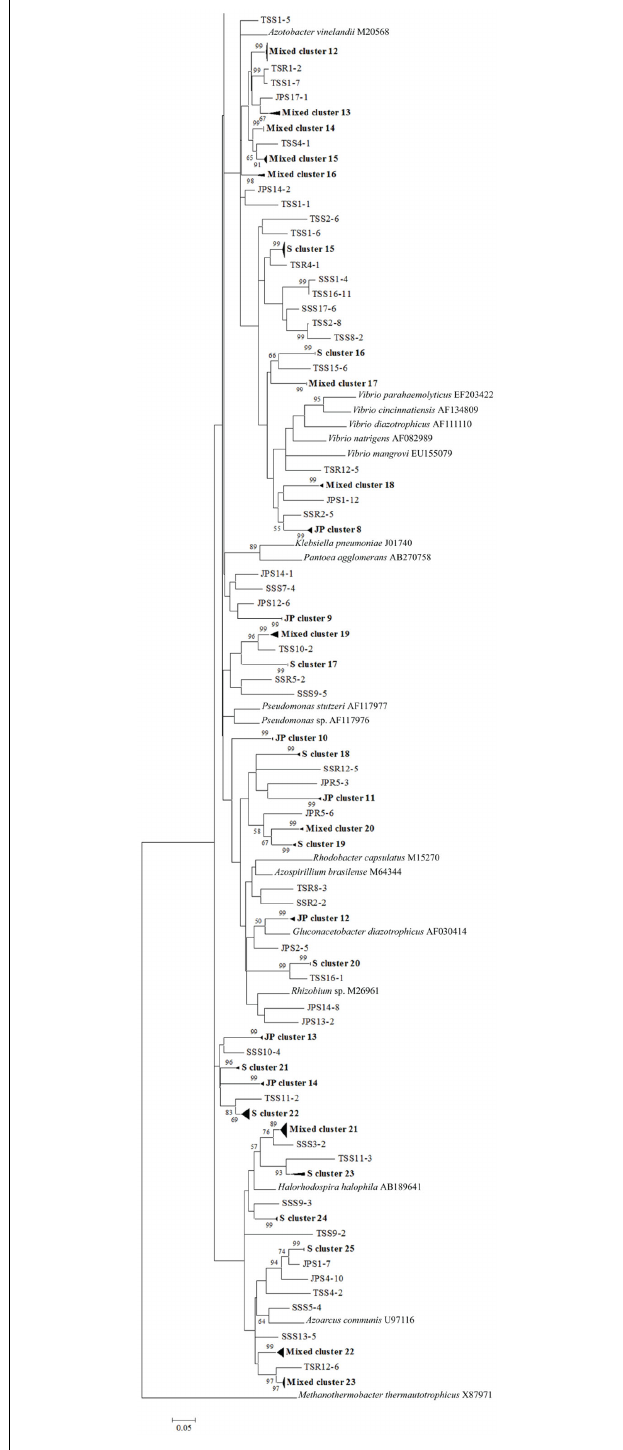
FIGURE 7 | Continuation of Figure 6 – phylogenetic analysis of all nifH sequences recovered from the low marsh plant zones (nucleotide sequences, Neighbor-Joining, Jukes Cantor correction, complete deletion of gaps and missing data, 1000 bootstrap replicates). Abbreviations: JP, J. roemerianus patch; SS, short form S. alterniflora ;TS, tall form S. alterniflora